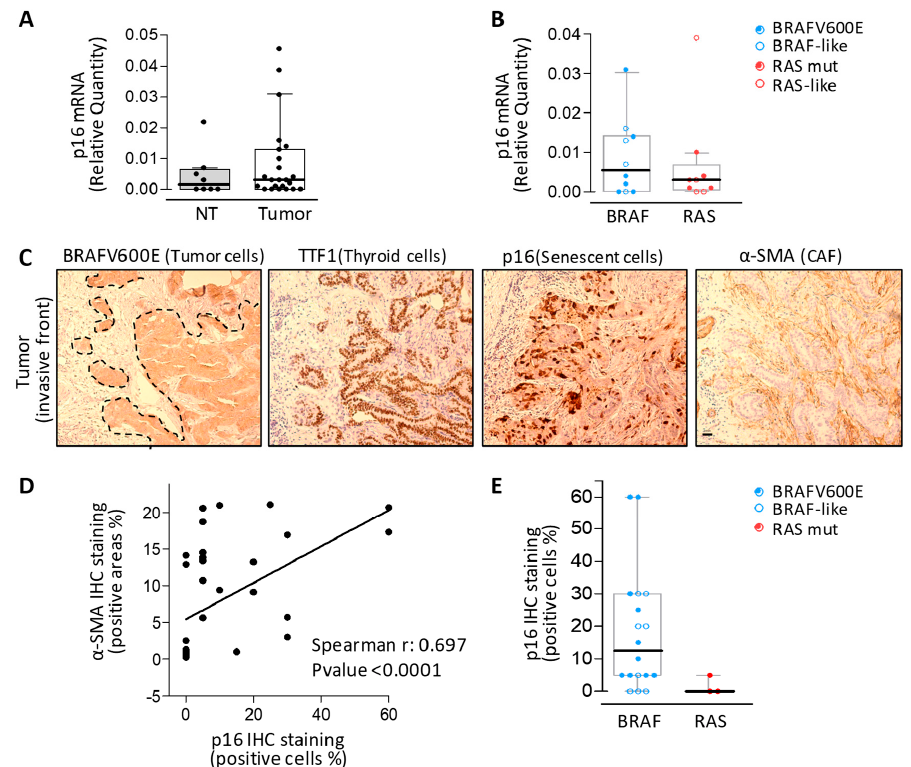
Figure 4. Senescent thyrocytes and CAFs assessment in human thyroid cancers. ( A ) Boxplot with a scatterplot of p16 mRNA expression by qRT-PCR in non-neoplastic thyroids (NT) and thyroid tumors and ( B ) in tumor samples stratified for driving lesion or BRAF-/RAS-like signaling. qRT-PCR data are shown as a relative quantity normalized to the HPRT gene used as an endogenous control. Each dot represents the mean of three technical replicates. ( C ) Representative serial sections of a BRAFV600E mutated thyroid tumor IHC stained with p16 and α -SMA (senescent cells and CAFs markers, respectively). Scale bar: 100 μ m. ( D ) Correlation between α -SMA positive areas and p16 positive cells established by IHC. ( E ) Boxplot with a scatterplot of p16 IHC staining results in tumors stratified for driving lesions or signaling.